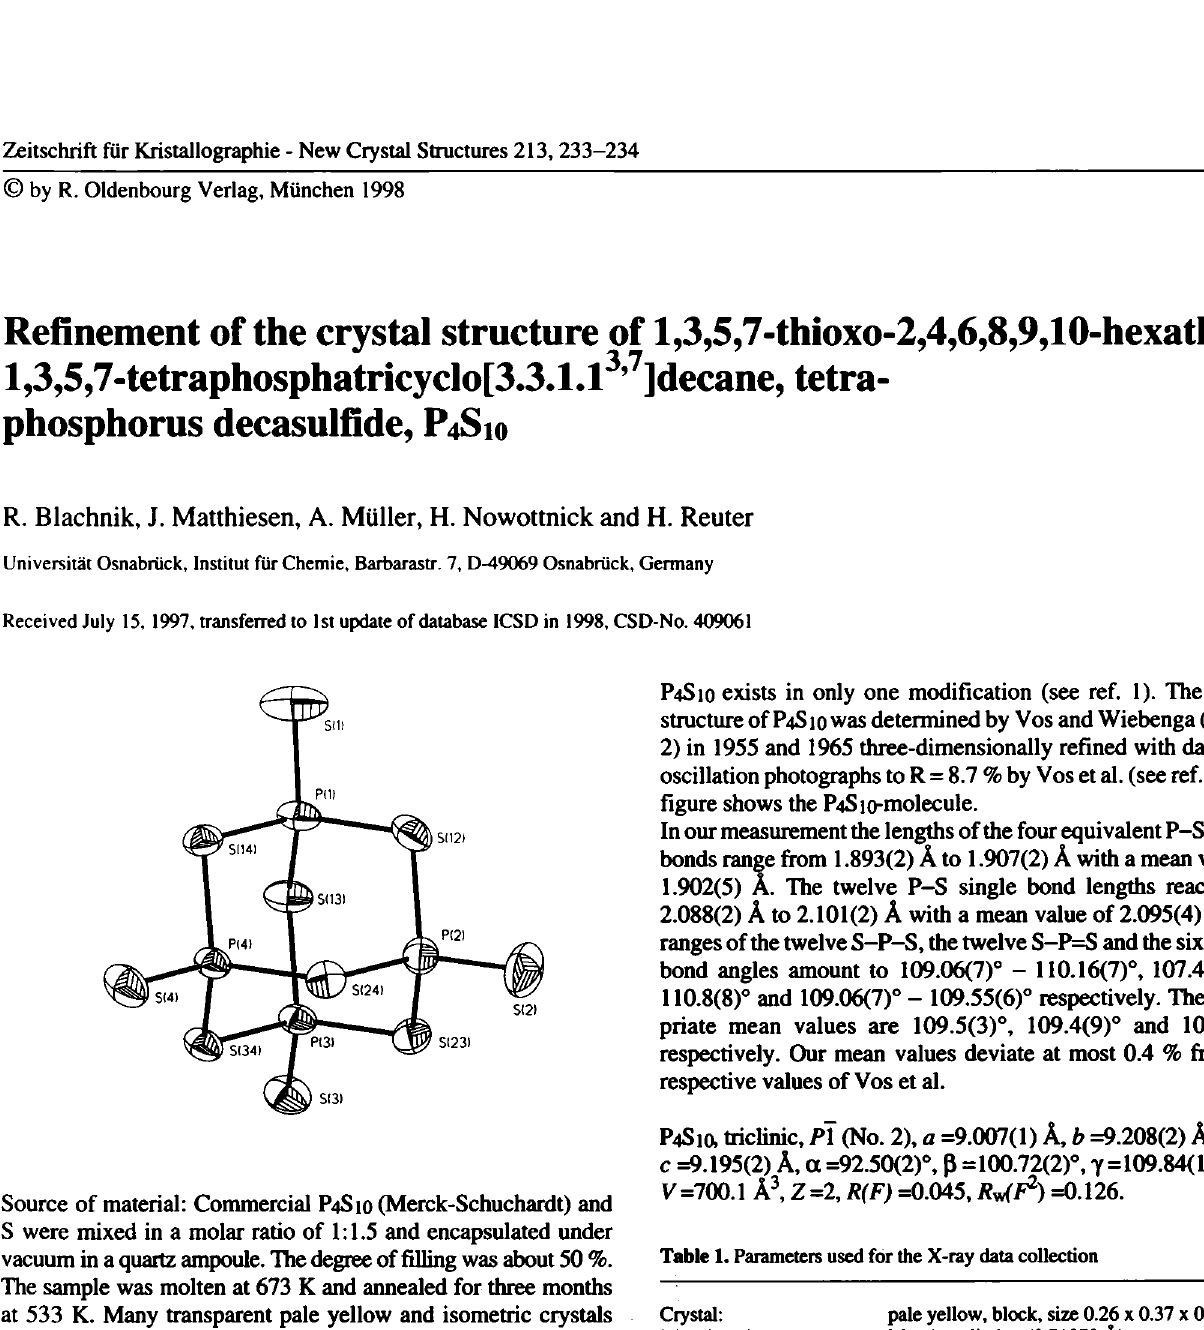
Table 2. Final atomic coordinates and displacement parameters (in Â^) Atom